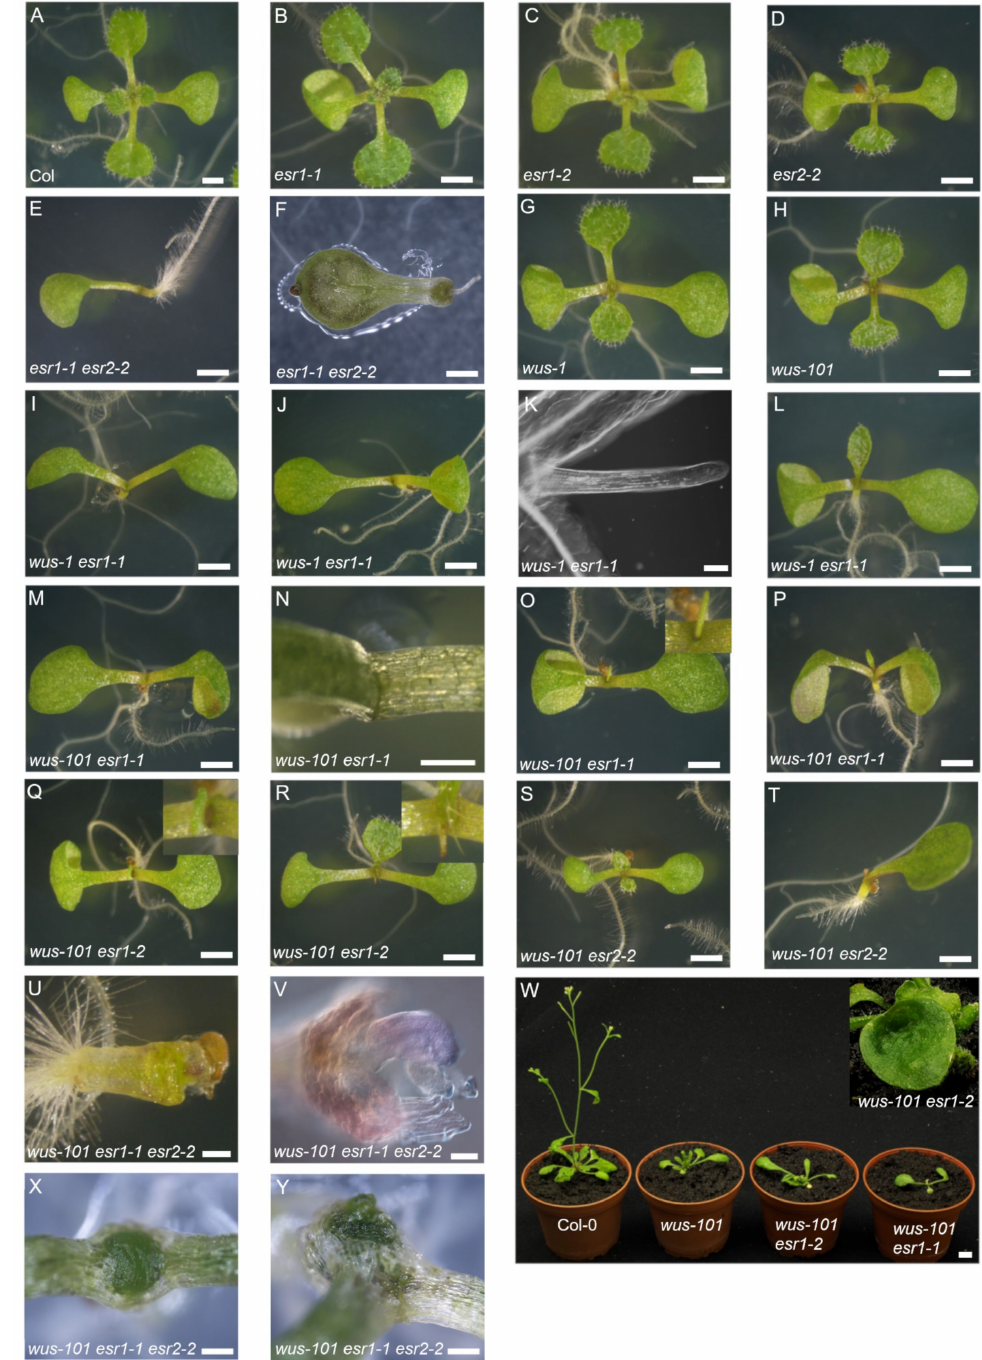
Figure 1. ESR1 controls rosette leaf development in the WUS-independent pathway in a dosage- dependent manner. ( A ) Eight-day-old Col-0; ( B ) esr1-1 ; ( C ) esr1-2 ; ( D ) esr2-2 ; ( E,F ) esr1-1 esr2-2 ; ( G ) wus-1 ; ( H ) wus-101 ; ( I – L ) wus-1 esr1-1 ; ( K ) Normarski image of the plant ( J ); ( M – P ) wus-101 esr1-1 ; ( N ) fourteen-day-old wus-101 esr1-1, note the radial structure (inset) in ( O ); ( Q , R ) eight-day-old wus-101 esr1-2, note the single radial structure (inset); ( S,T ) wus-101 esr2-2 ; ( U ) wus-101 esr1-1 esr2-2 ; ( V ) Nomarski image of the shoot apex of seedling ( U ); ( W ) thirty-day-old plants of Col-0, wus-101, wus-101 esr1-2, and wus-101 esr1-1 (from left to right), note the lotus-like leaf of wus-101 esr1-2 (inset); ( X , Y ) thirty-day-old wus-101 esr1-1 esr2-2 shoot apex. Scale bars = 1 mm (A–E, G–J, L–T,W), 0.5 mm ( F,U,X,Y ), and 0.2 mm ( K,V